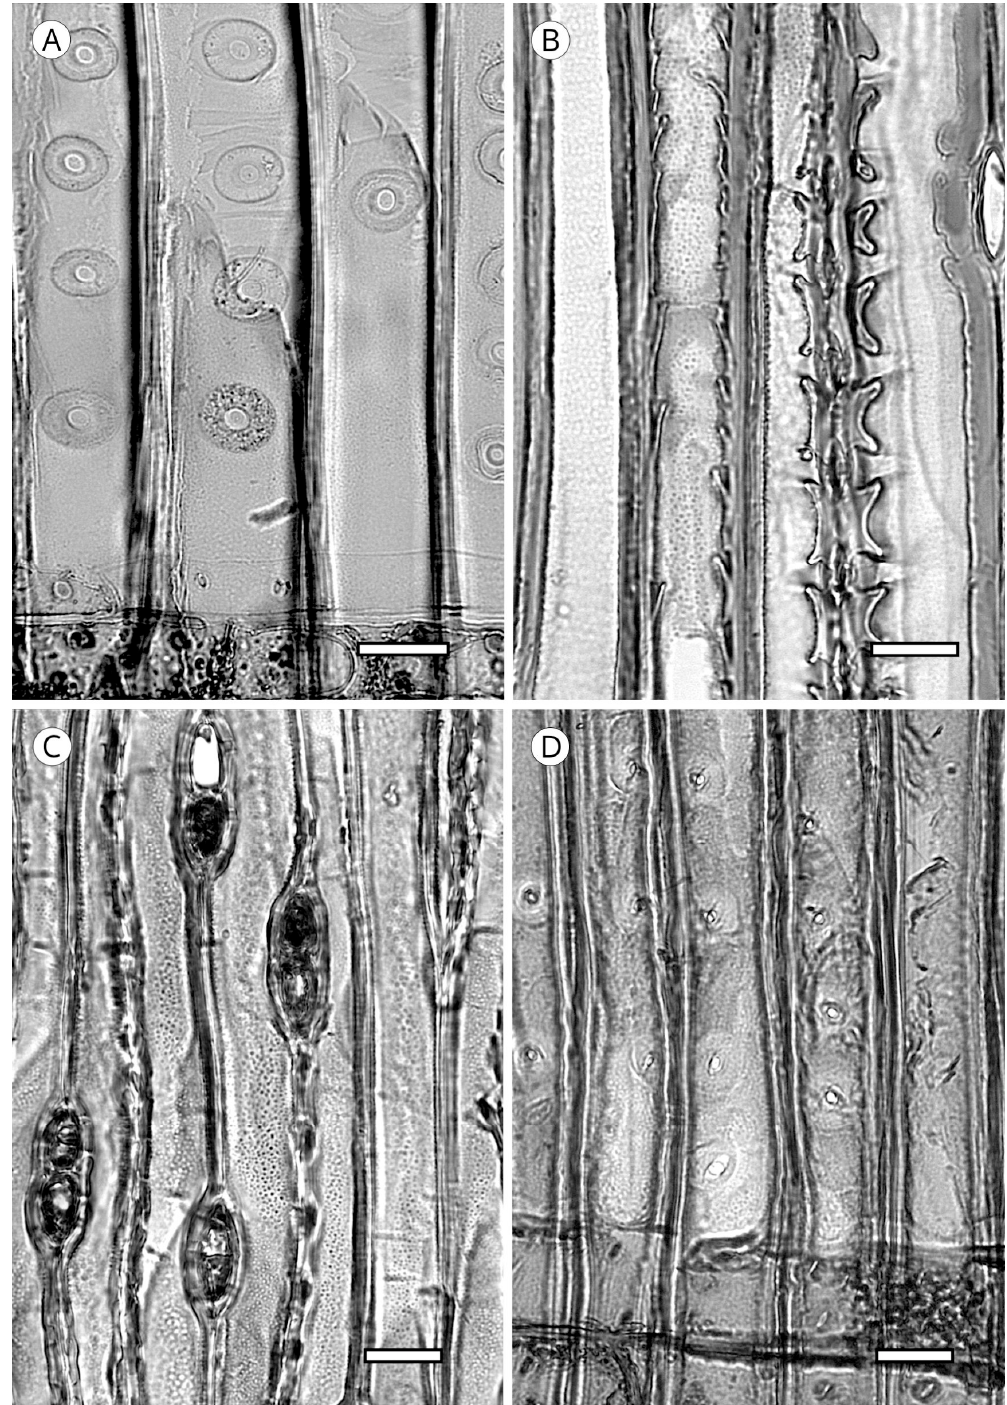
Figure 17. Warty layer (light microscopy). ( A ) Abies spectabilis (D.Don) Mirb.; ( B ) Callitris endlicheri (Parl.) F.M.Bailey; ( C ) Juniperus californica Carrière; ( D ) Tetraclinis articulata (Vahl) Mast. Scale bars. ( A – D ) = 25 μ m.